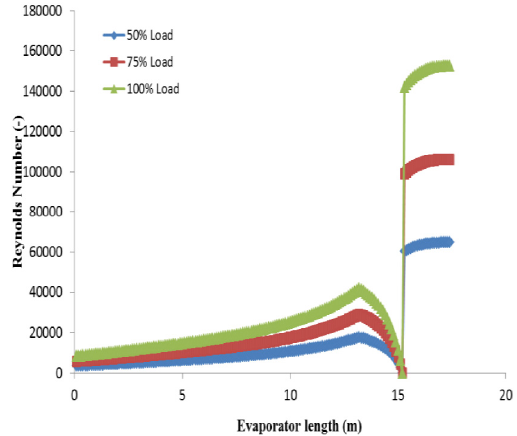
Fig. 5. Reynolds number of